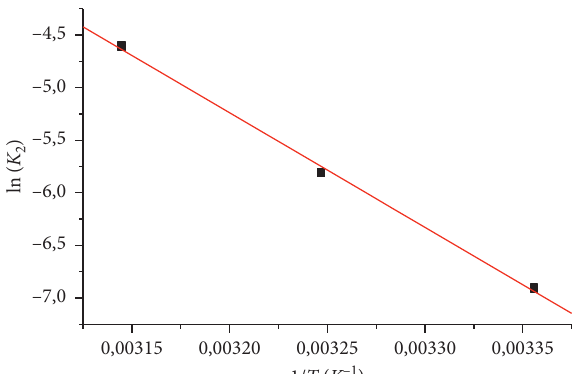
Figure 10: Arrhenius slope for adsorption of